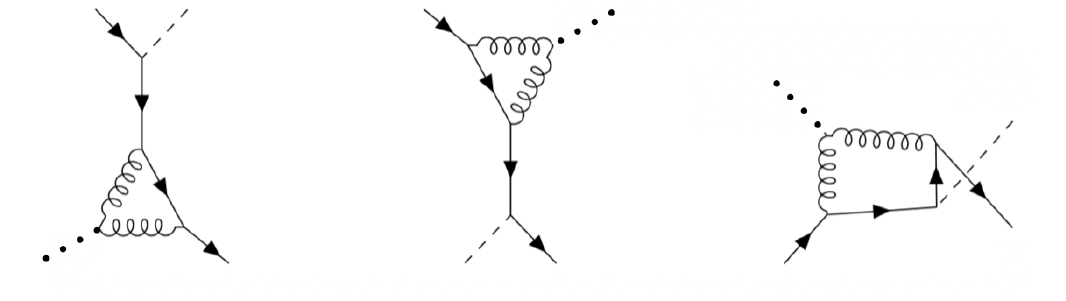
Figure 5 . Diagrams containing contributions from G ~ G in (4.11). The dotted line represents a